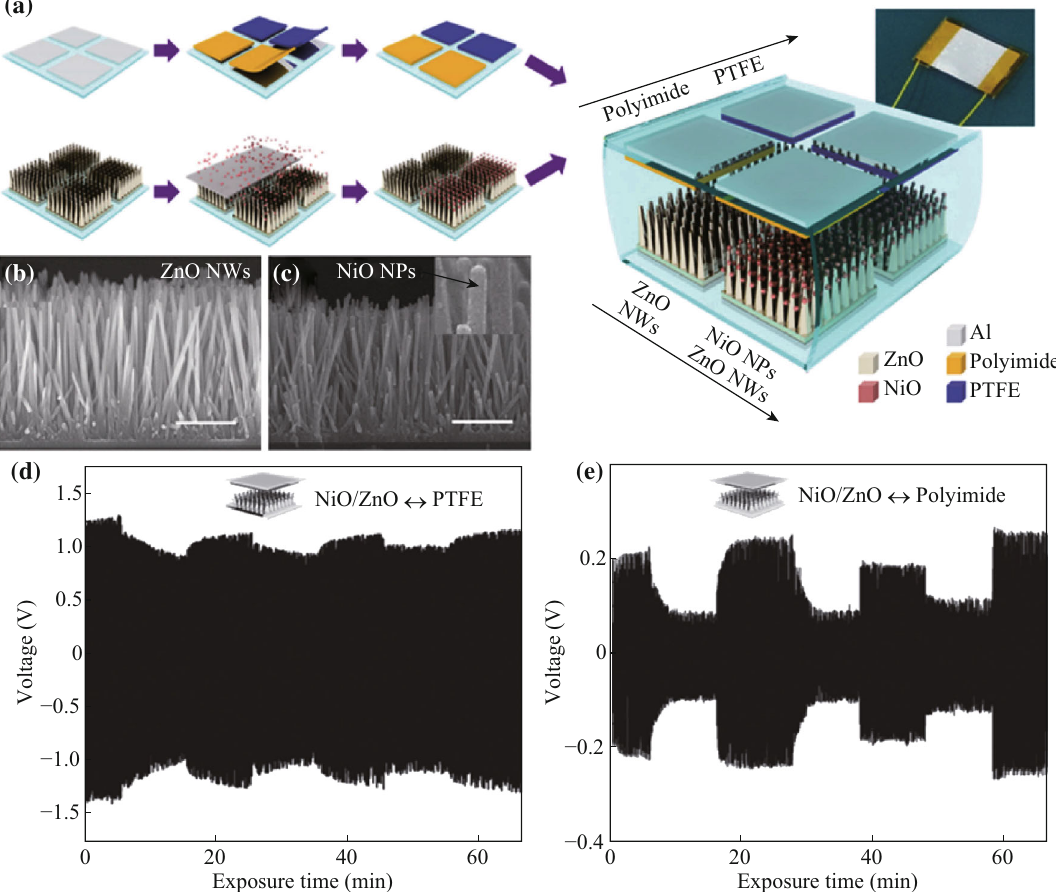
Fig. 8 A self-powered, room-temperature electronic nose based on triboelectrification and heterogeneous catalytic reaction. a Schematic illustration of the fabrication process of a self-powered electronic nose and an optical image of the as-fabricated device. SEM images of b the ZnO NWs and c the NiO nanoparticle-decorated ZnO NWs grown on the SiO 2 /Si ( Scale bar , 500 nm). The output performance of the sensor elements comprising d NiO nanoparticle-decorated ZnO-PFTE and e NiO nanoparticle-decorated ZnO-PI under cycled compressive force of 50 N at an applied frequency of 4 Hz. Figures adapted from